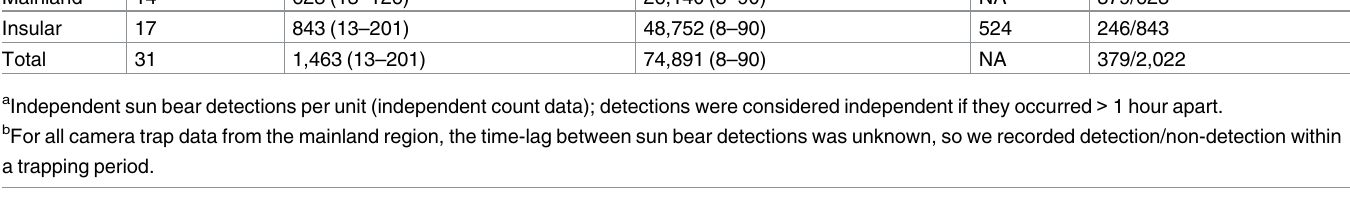
Table 1. Cameratrap sun bear detection data, collected between 2000–2015,were combined from 31 field sites in 7 out of 11 sun bear range countries.